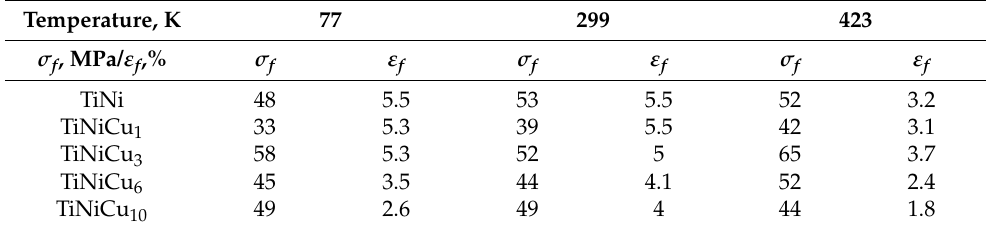
Table 4. Fracture stress and strain to fracture values for porous TiNi alloys. Temperature,